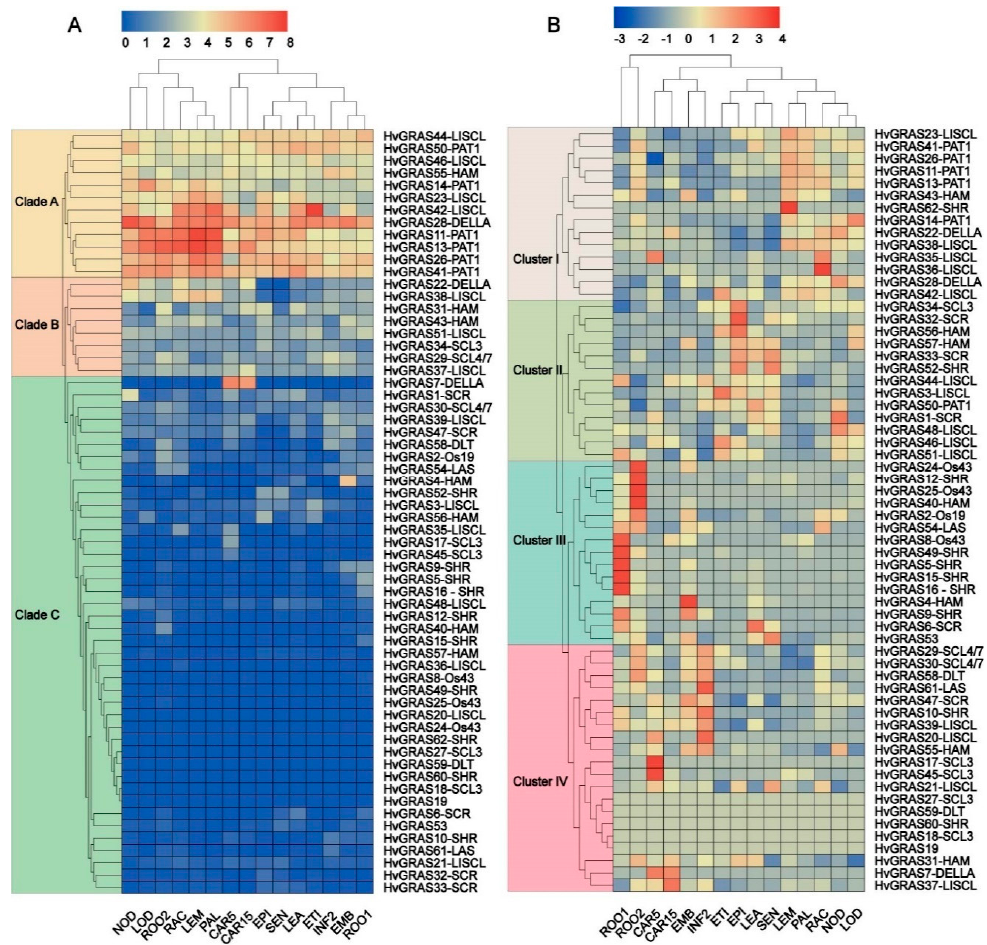
Figure 4. Gene expression profile of GRAS family member in barley (Morex cultivar) in different tissue. Expression profile of different tissue developing root, shoot, inflorescences and seedling stage were performed in barley. EMB, 4-day embryos; ROO1, roots from seedlings (10 cm shoot stage); LEA, shoots from seedlings (10 cm shoot stage); INF2, developing inflorescences (1–1.5 cm); NOD, developing tillers, 3rd internode (42 DAP); CAR5, developing grain (5 DAP); CAR15, developing grain (15 DAP); ETI, etiolated seedling, dark cond; LEM, inflorescences, lemma (42 DAP); LOD, inflorescences, lodicule (42 DAP); PAL, dissected inflorescences, palea (42 DAP); EPI, epidermal strips (28 DAP); RAC, inflorescences, rachis (35 DAP); SEN, senescing leaves (56 DAP). (10 DAP); ROO2, roots (28 DAP). ( A ) heat map is separated based on the high (Clade A), moderate (Clade B) and low (Clade C) expression. ( B ) heat map is performed by clusters row and column, Euclidean distribution method is applied to categorize similar expression pattern to one group (Cluster I to Cluster IV).